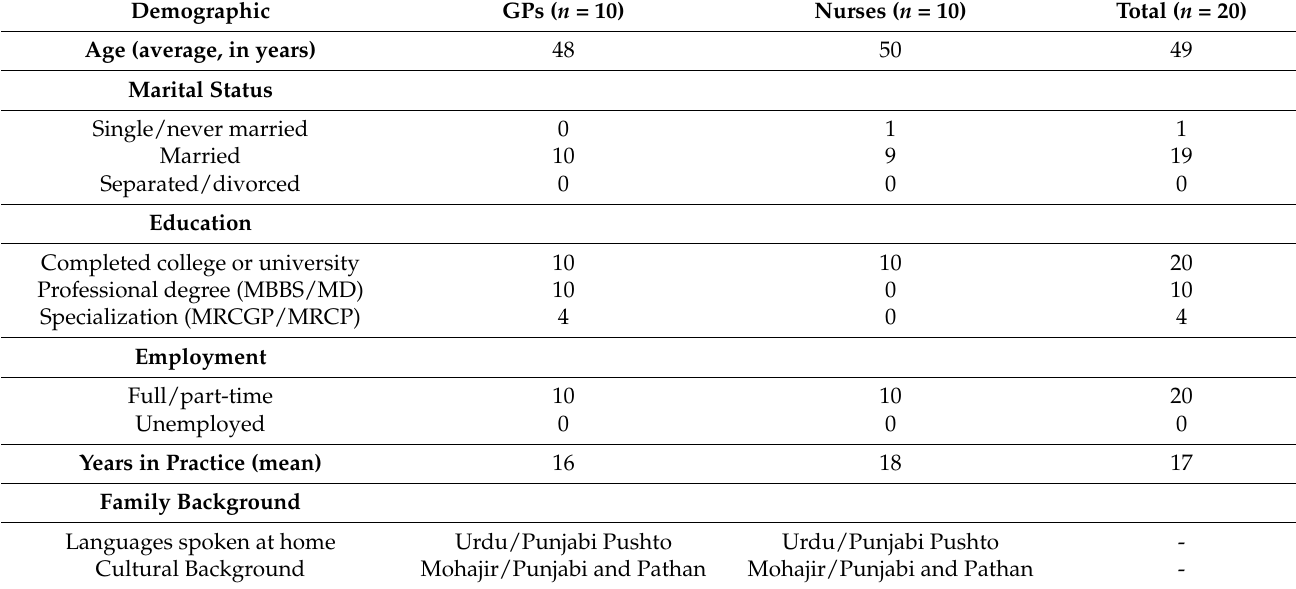
Table 1. The summary of participants’